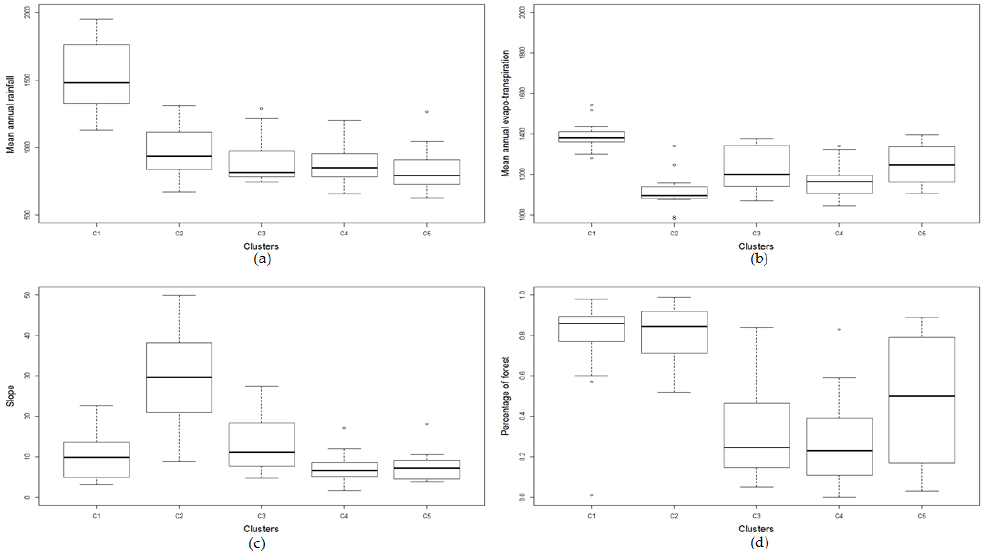
Figure 8. Boxplots of mean annual rainfall, mean annual evapo-transpiration, slope and fraction forest for all the clusters: (a) boxplot of mean annual rainfall; (b) boxplot of mean annual evapo-transpiration; (c) boxplot of slope; and (d) boxplot of fraction forest.